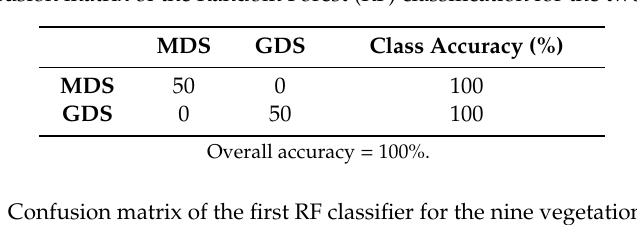
Table 3. Confusion matrix of the Random Forest (RF) classification for the two sand classes.